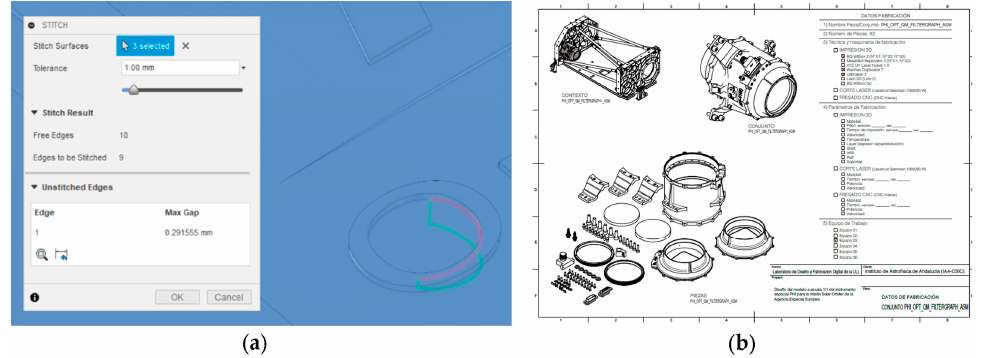
Figure 3. ( a ) Open surface detected through Stitch tool. ( b ) Subassembly 8 plan.